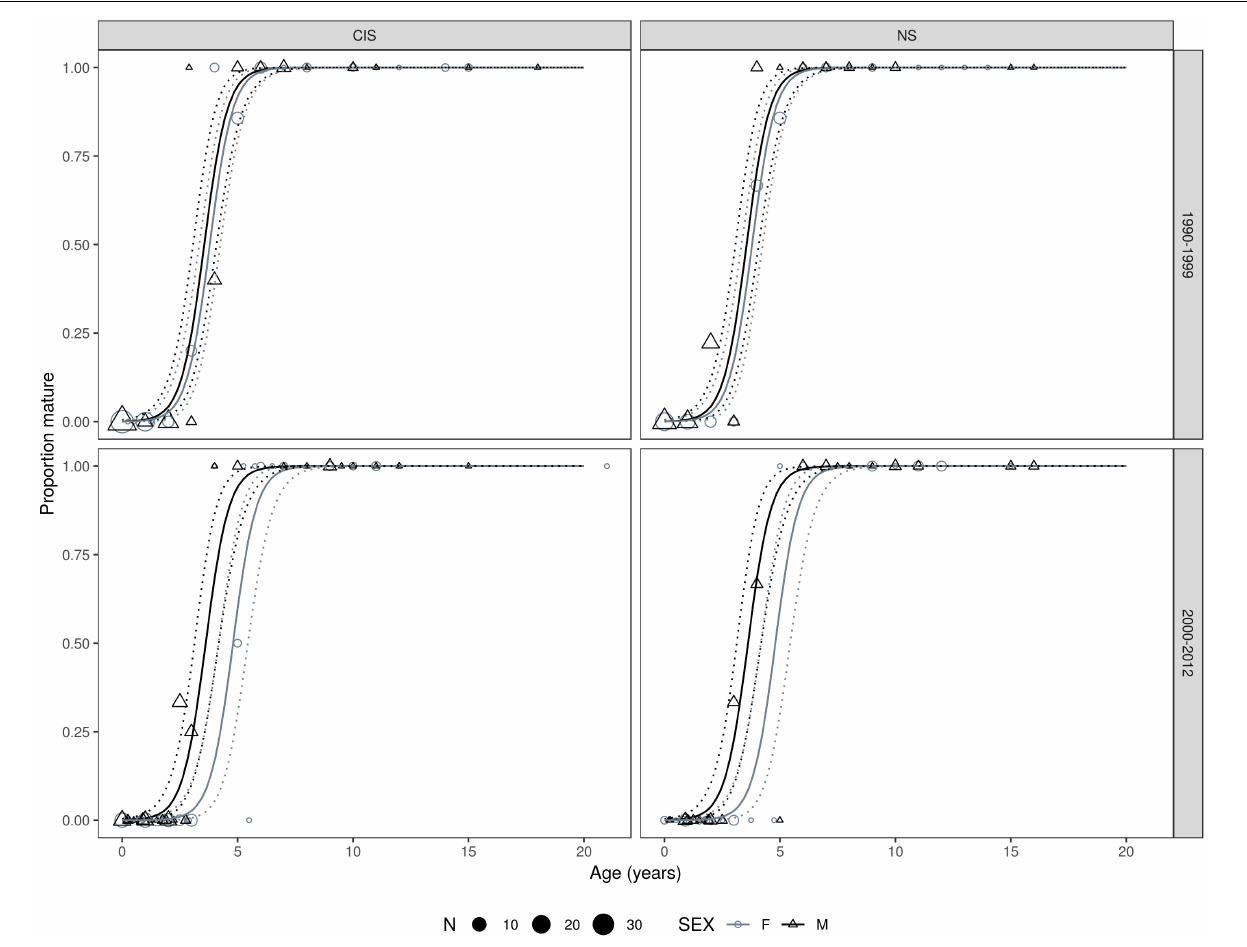
FIGURE 6 | Best fitting age (years) at maturity model fits by management unit, time period, and sex. Points are scaled proportional to the number of observations for a given proportion. Solid and dashed curves represent the mean and 95% confidence intervals on the estimated proportion mature,